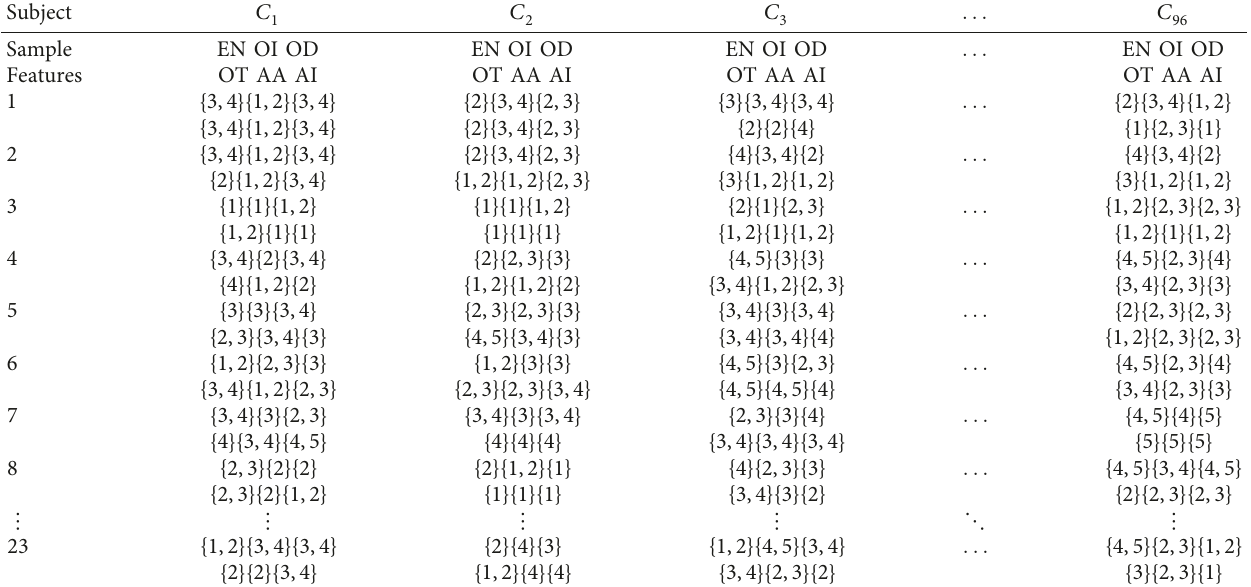
Table 3: Questionnaire hesitant-fuzzy cognitive